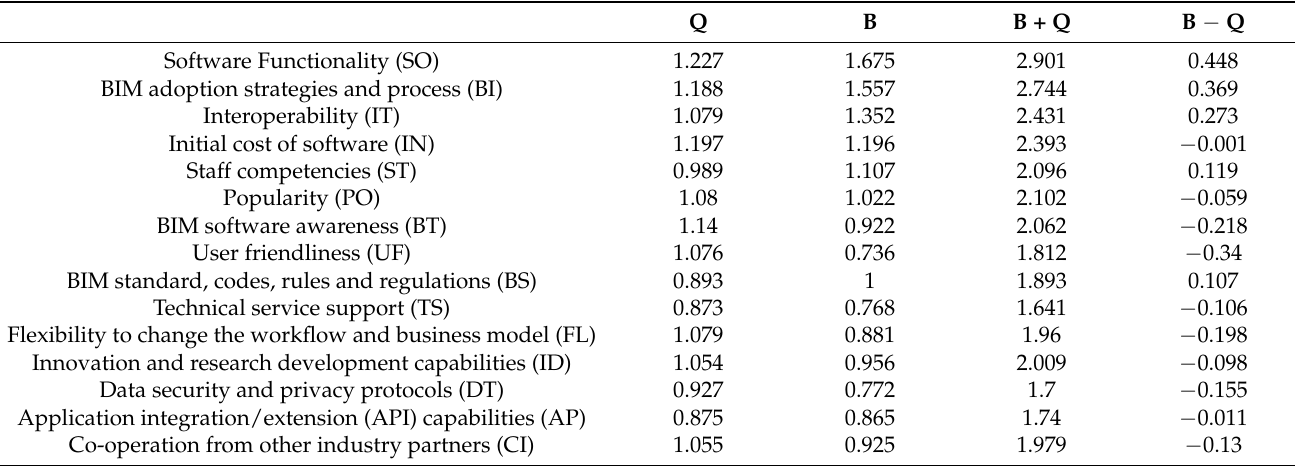
Table 12. Crisp values of